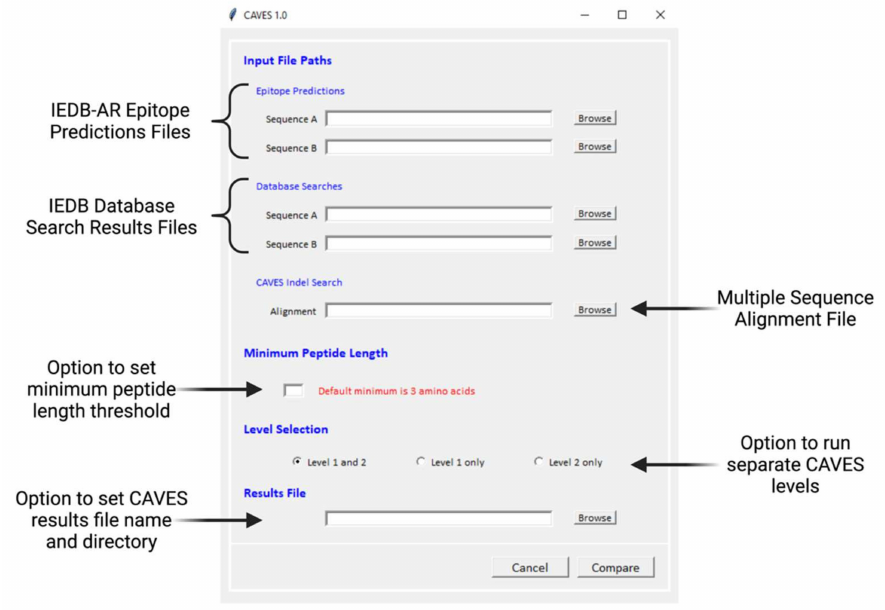
Figure 2. CAVES graphical user interface (GUI). CAVES opens as a single page and is compatible with Windows OS. The required fields are the epitope prediction files, database search files, and multiple sequence alignment files under the Input File Paths header. The Minimum Peptide Length , Level Selection , and Results File fields are optional parameters set to defaults unless otherwise